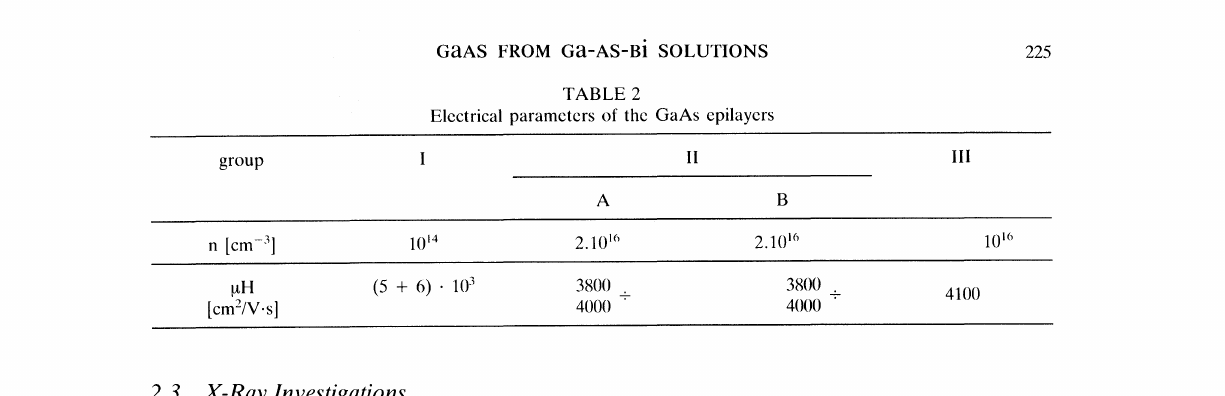
TABLE 2 Electrical parameters of the GaAs